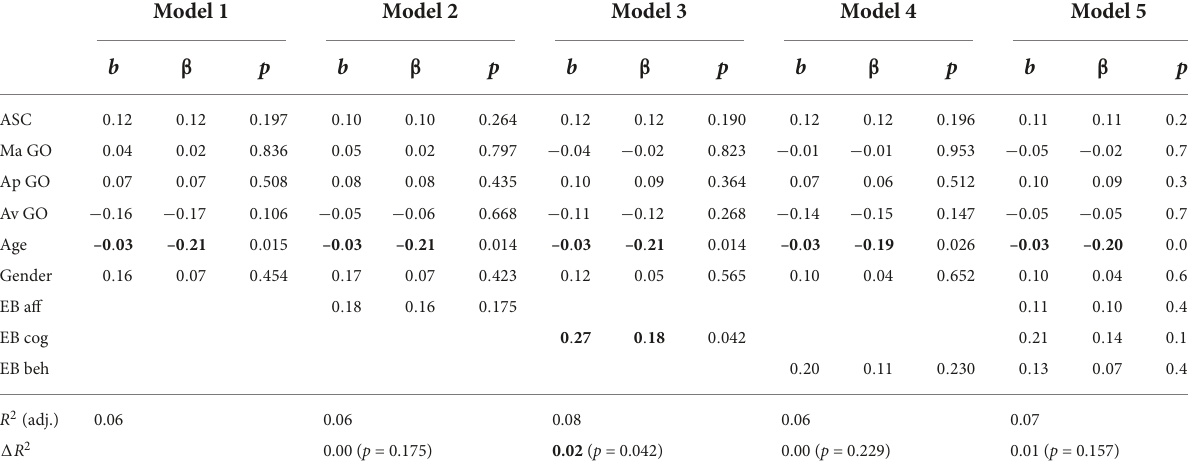
TABLE 3 Stepwise linear regression predicting academic risk taking (peer